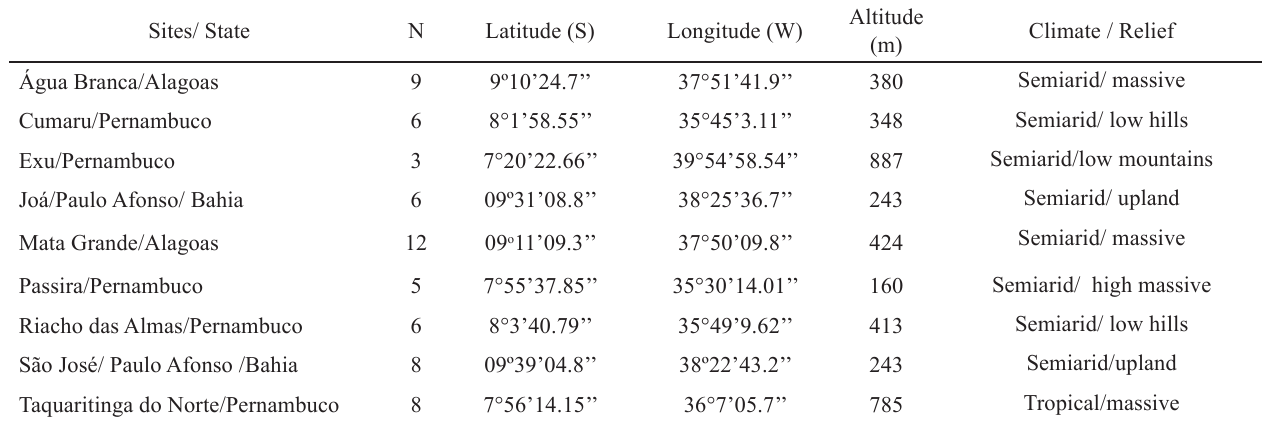
Table 1. Origin and geographic location of the Melipona subnitida samples at the Southern Limit of its Distribution natural in Brazil. N- number of